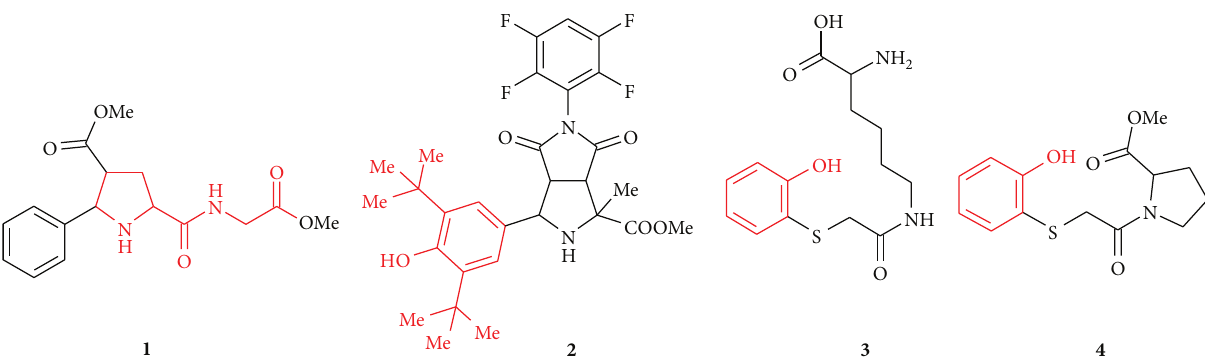
Figure 1: Structural formula of small-molecule agents synthesized and studied in the present work. Substructures with known antioxidant activity are shown in